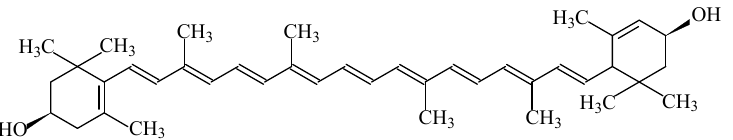
Figure 10. Structural formula of lutein (E161b).